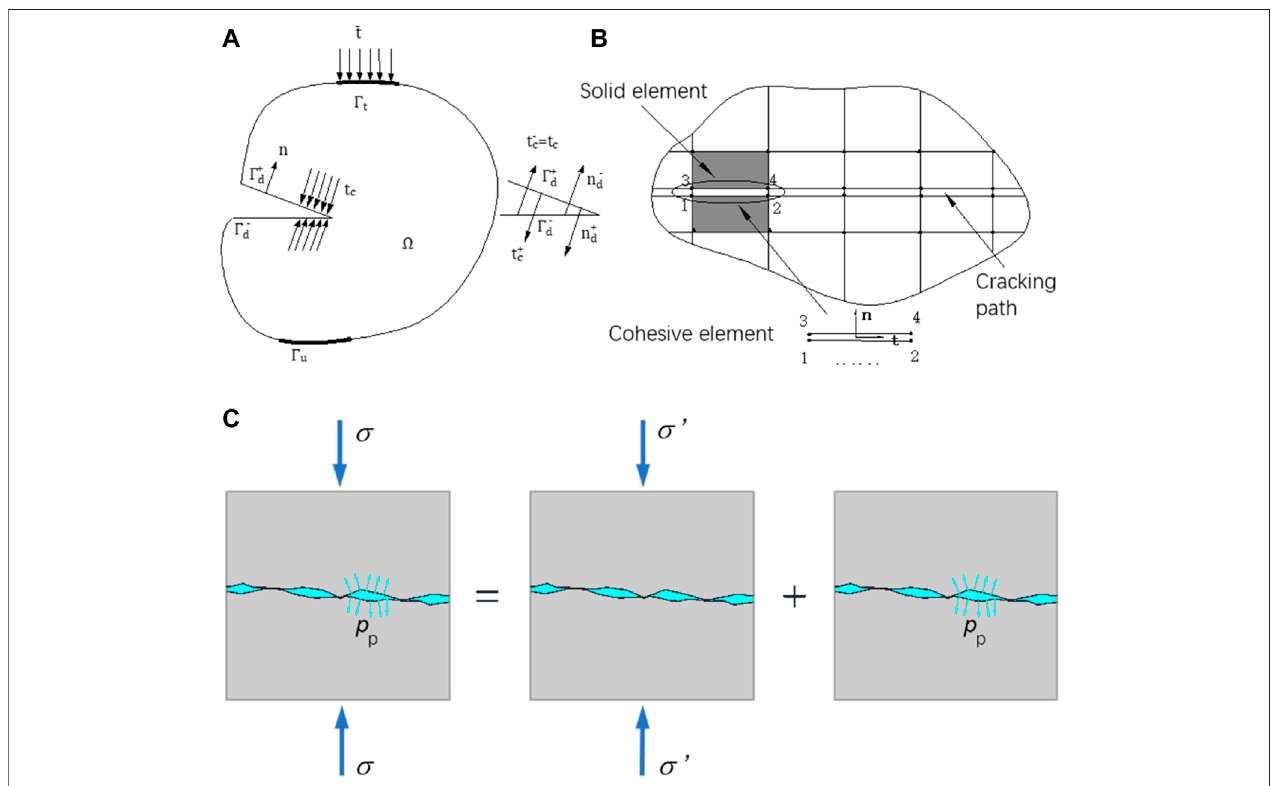
FIGURE 1 | (A) Schematic diagram of cohesive element simulating cracking of rock material; (B) Schematic diagram of joint crack propagation simulated by cohesive element; (C) Schematic diagram of stress seepage coupling of joints and fi